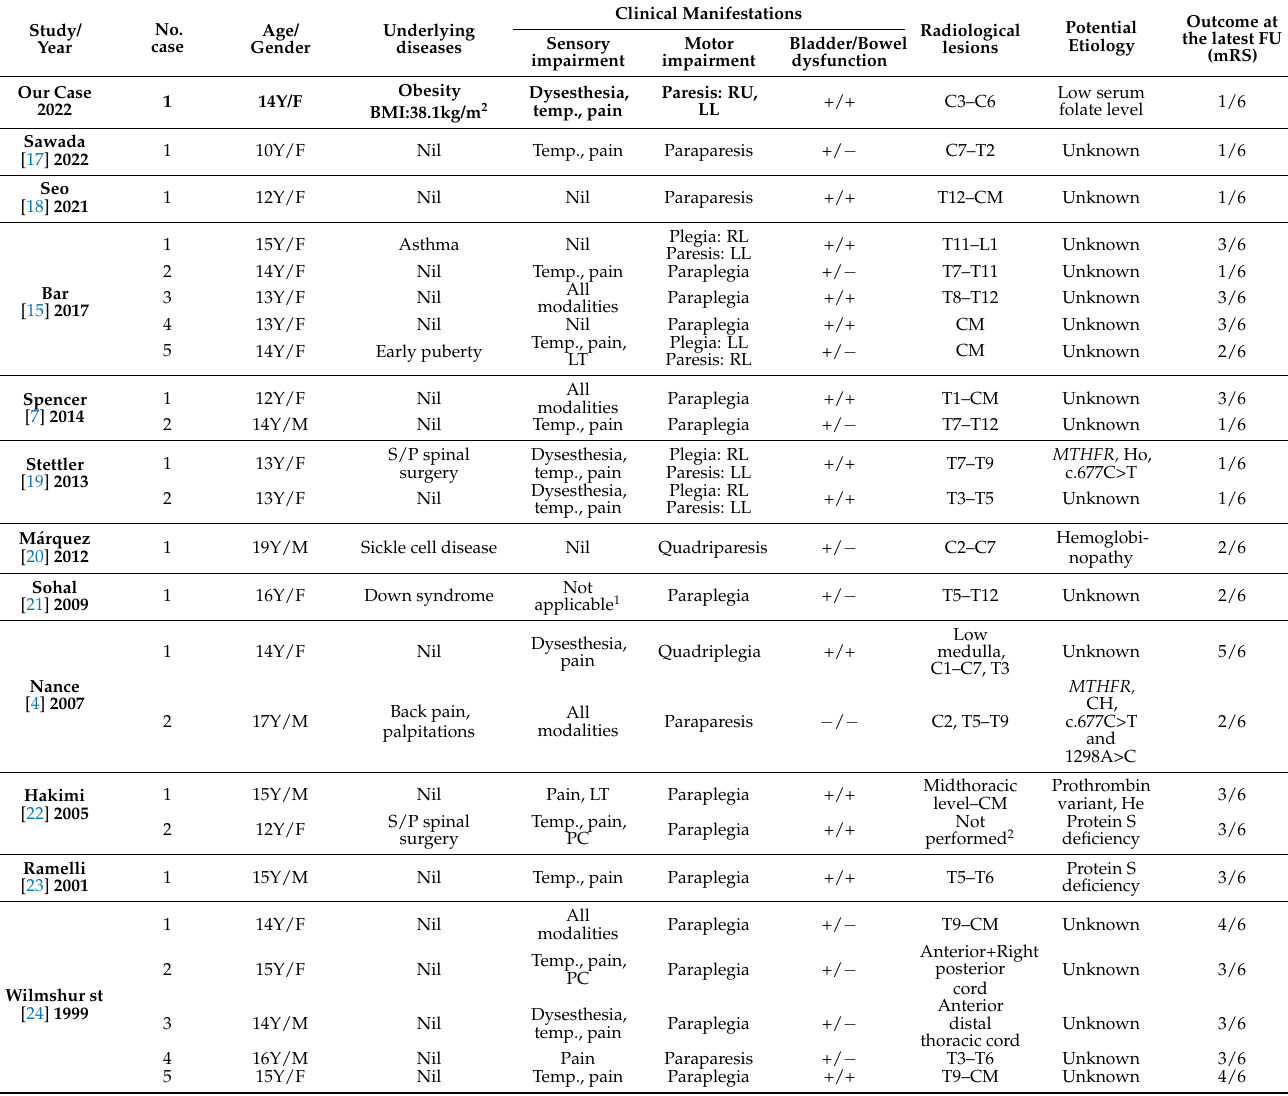
Table 2. Comparison of cases with the diagnosis of nontraumatic ASAS in